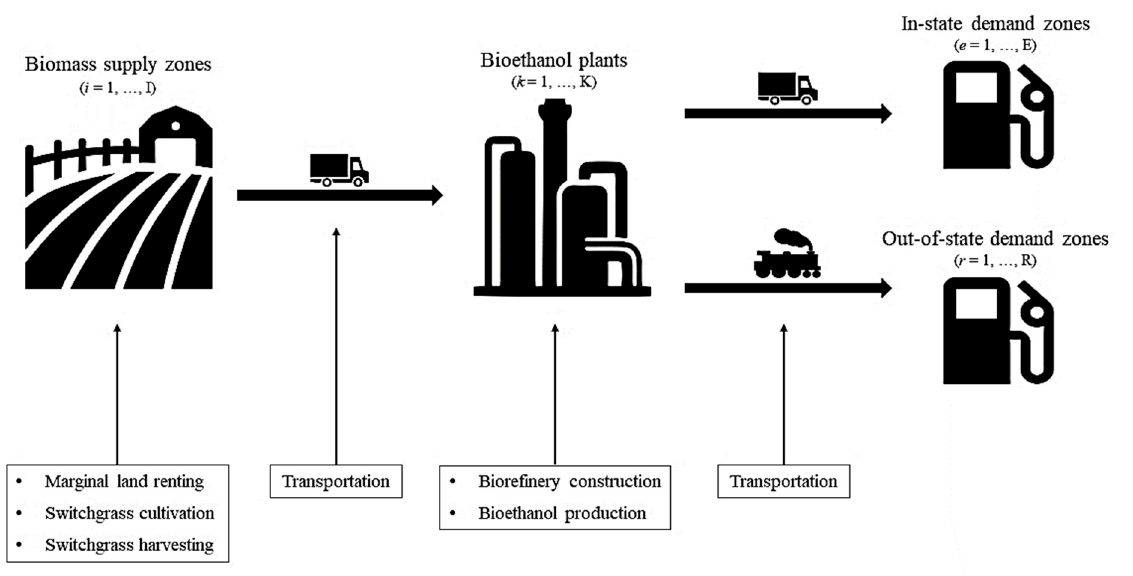
Figure 1. SBSC network and the associated activities with each stage (indices i , k , e , and r represent sets of supply zones, plants, in ‐ state demand zones, and out ‐ of ‐ state demand zones, respectively).